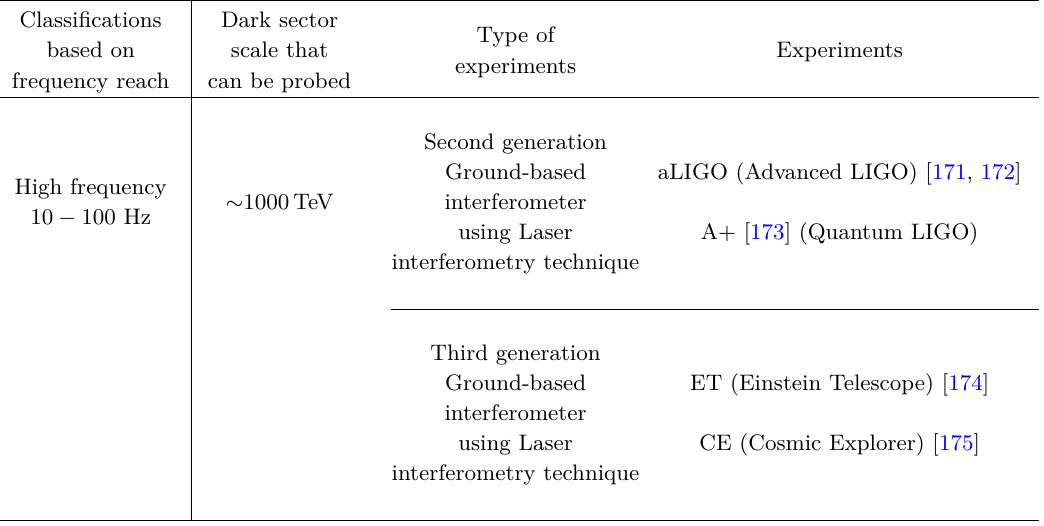
Table 1. Description of upcoming gravitational wave observatories, including the frequency range to which they would be sensitive, and the correspond symmetry-breaking